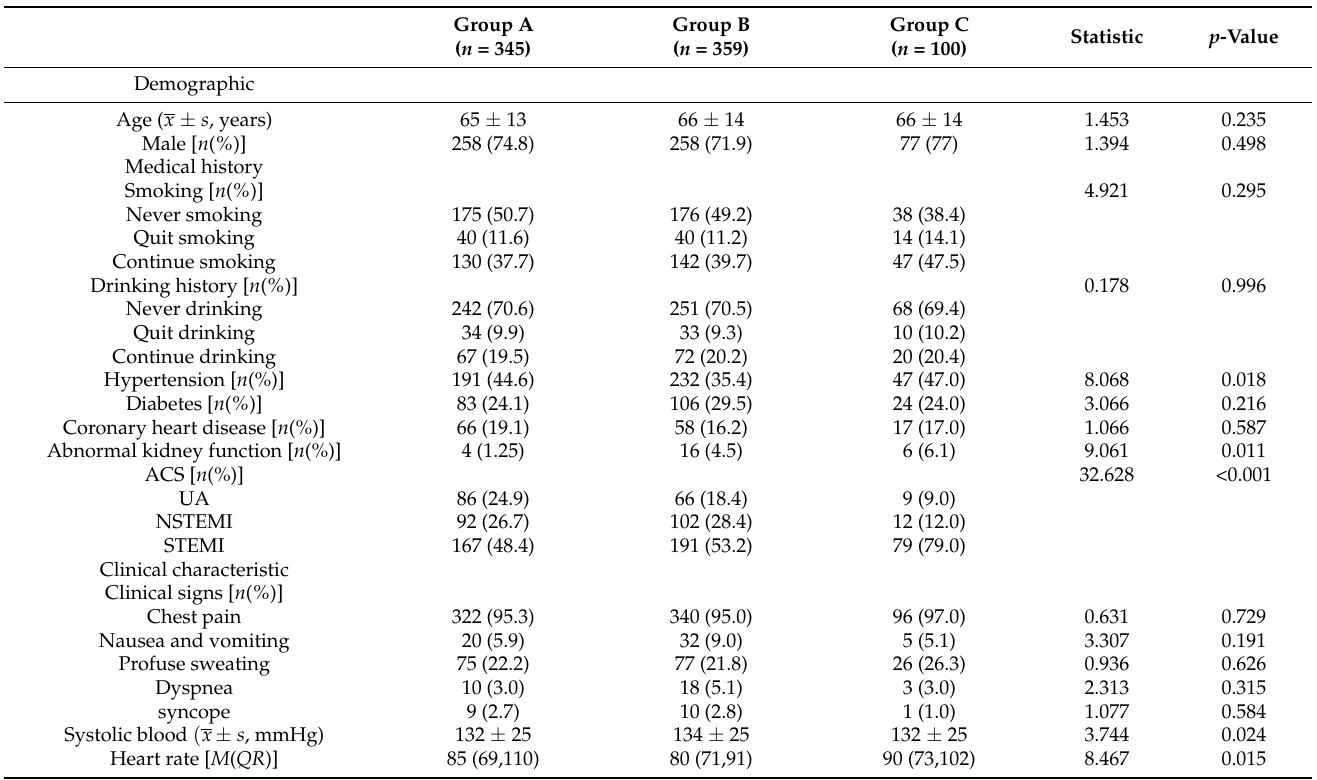
Table 1. Baseline